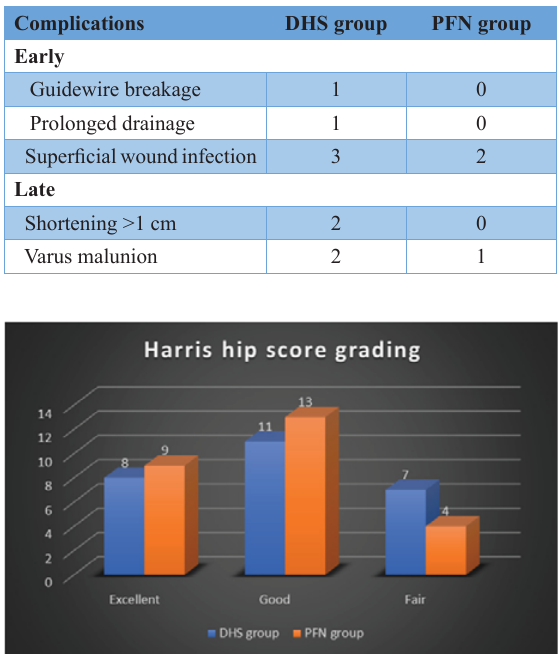
Table 4. Complications between DHS and PFN groups